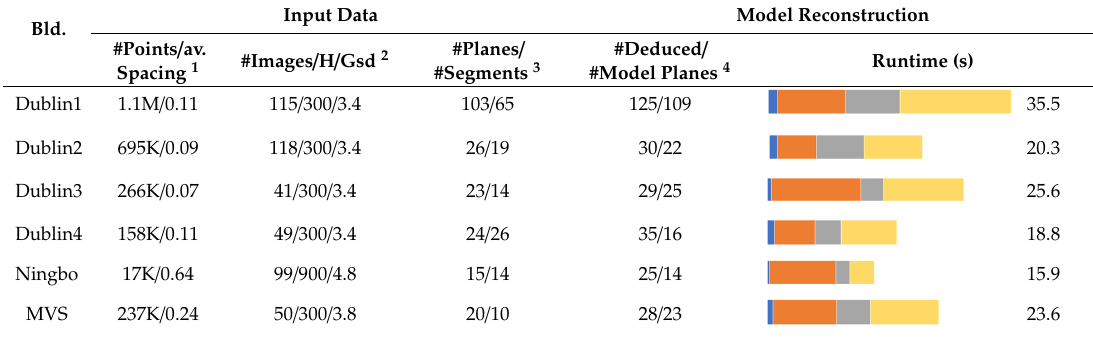
Table 2. Data properties and quantitative statistics.